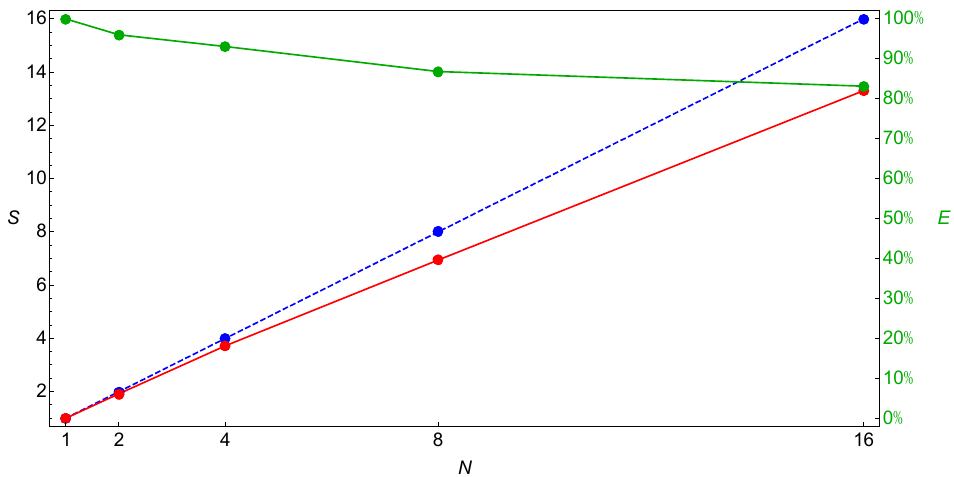
Table 2. Speedup and parallelization efficiency for the sPMEC algorithm. Number of Nodes, N